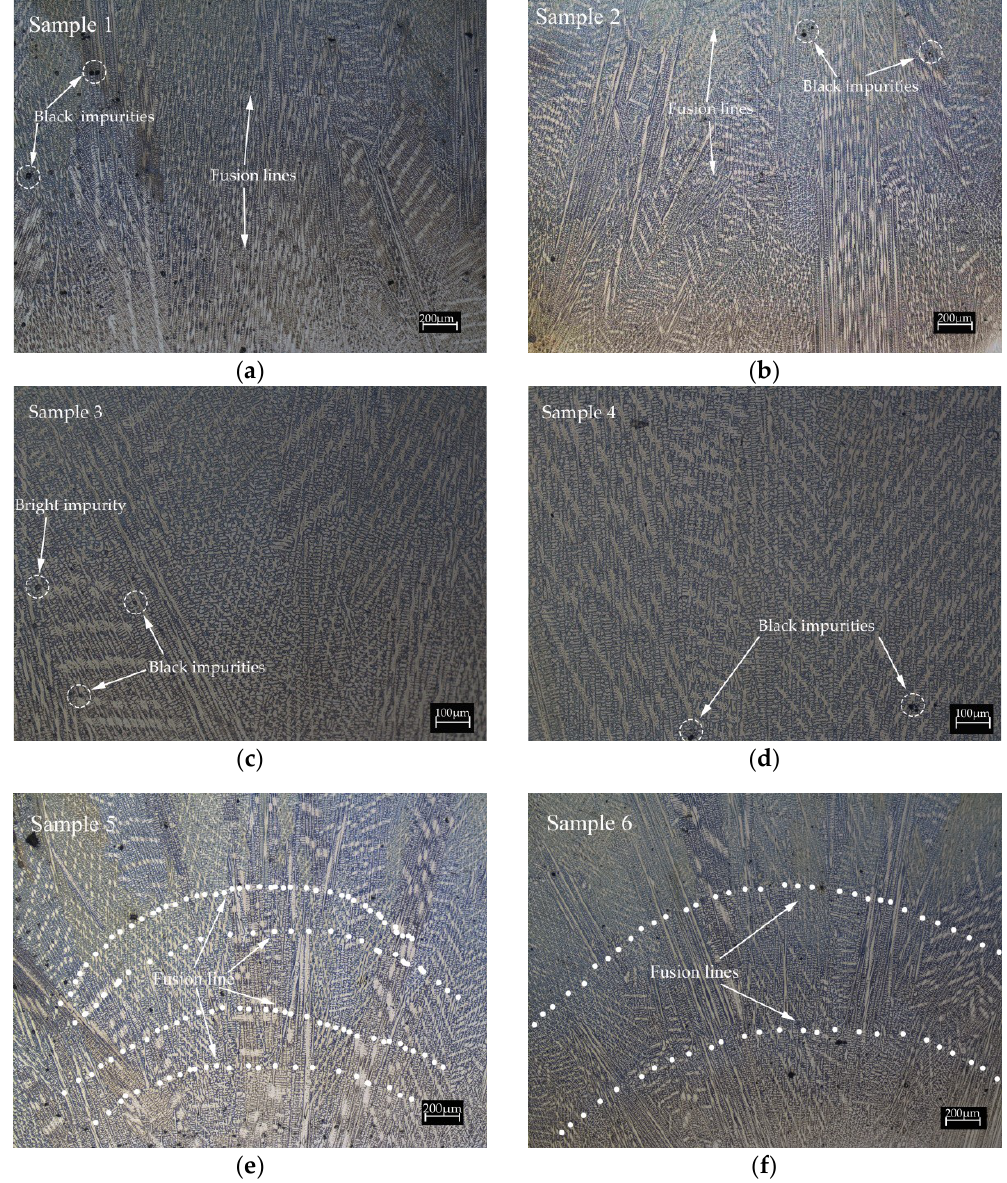
Figure 4. Optical microscopy (OM) images of 6 groups about fusion lines and impurities: ( a ) fusion lines and black impurities in Sample 1; ( b ) fusion lines and black impurities in Sample 2; ( c ) bright and black impurities in Sample 3; ( d ) black impurities in Sample 4; ( e ) fusion lines in Sample 5; and ( f ) fusion lines in Sample 6.